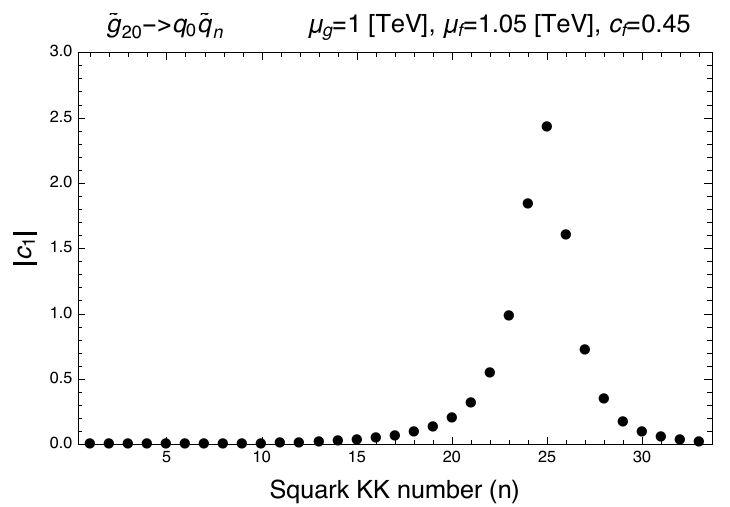
Figure 5. The coupling (3.6) between the 20th KK gluino, zero mode quark, and KK squarks, with z IR = 0 : 1 GeV (cid:0) 1 .